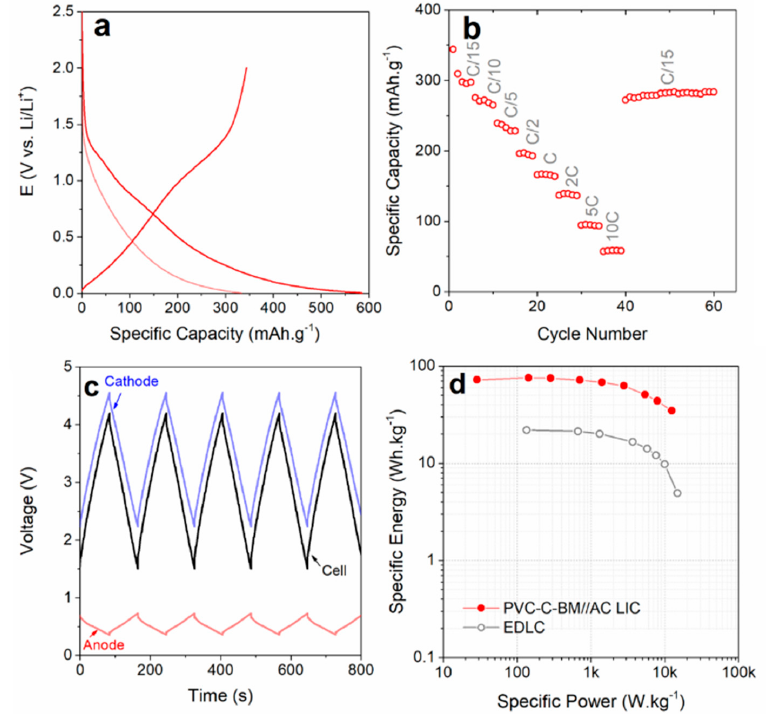
Figure 6. Lithium storage performance of the PVC-derived soft carbon (PVC-C-BM) as the negative